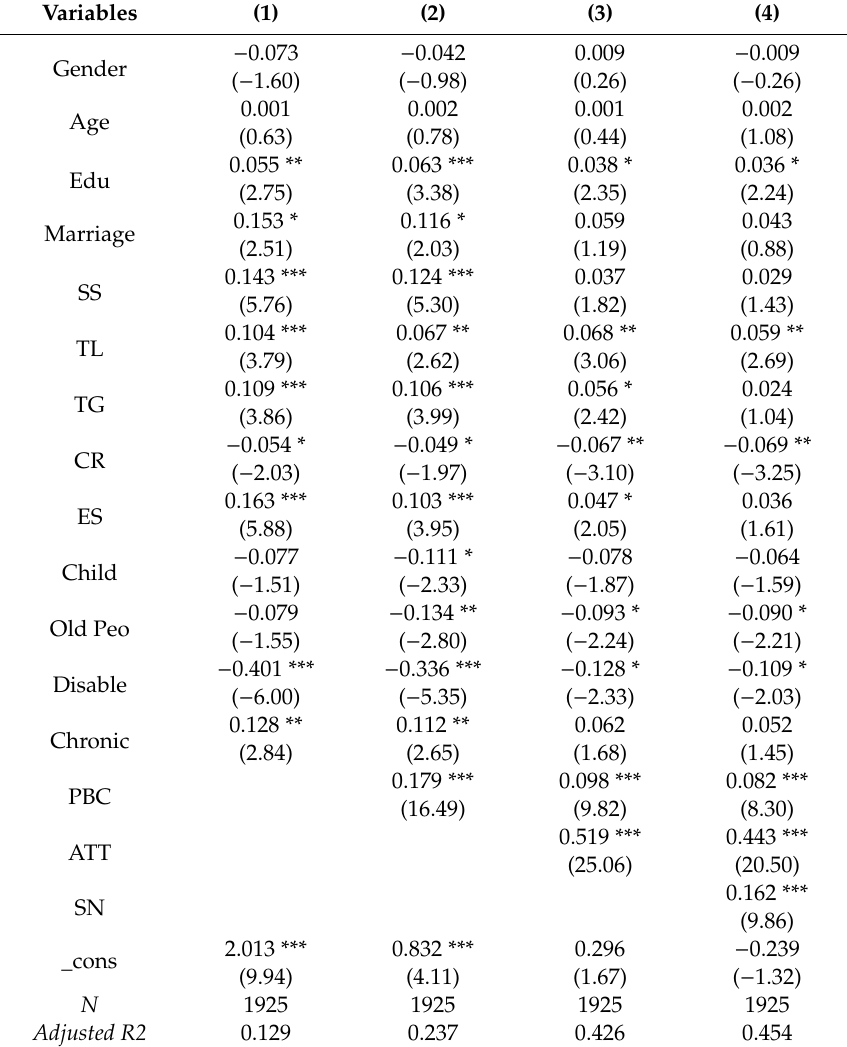
Table 4. The multiple linear regression models ( N =